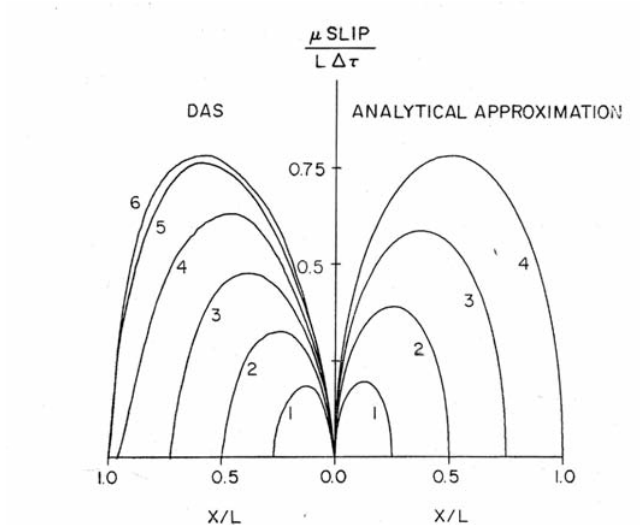
Figure 9. Slip functions obtained as a numerical solution of a crack problem on the left and those approximated by a sequence of ellipses used in calculating the synthetic seismogram at Pacoima at Dam. Reproduced from Bouchon